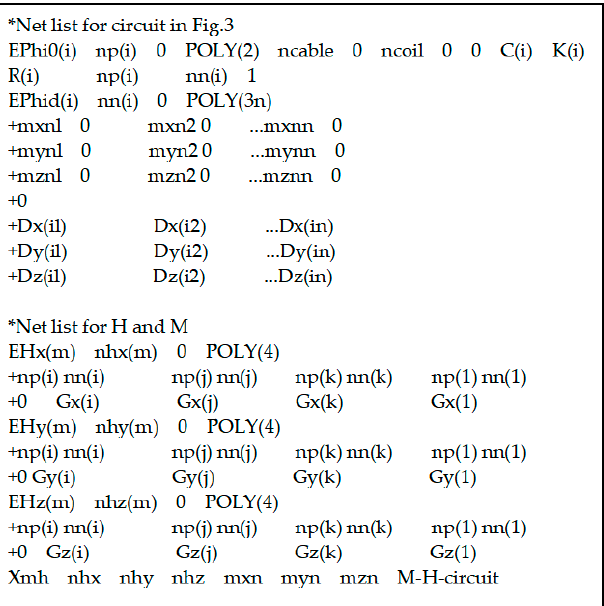
Figure 5. Netlist for the i -th node circuit (Figure